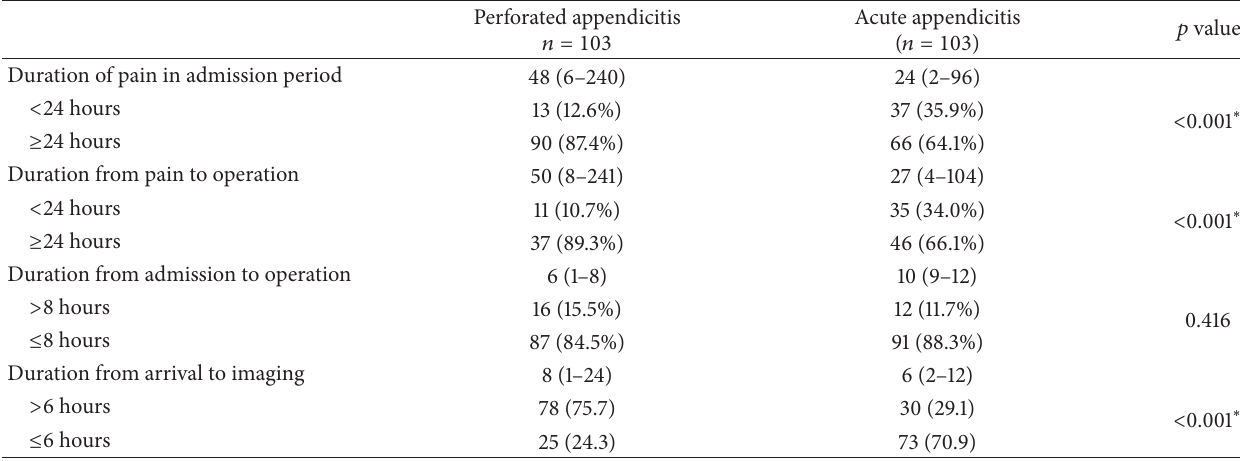
Table 3: Duration of time in perforated and acute appendicitis